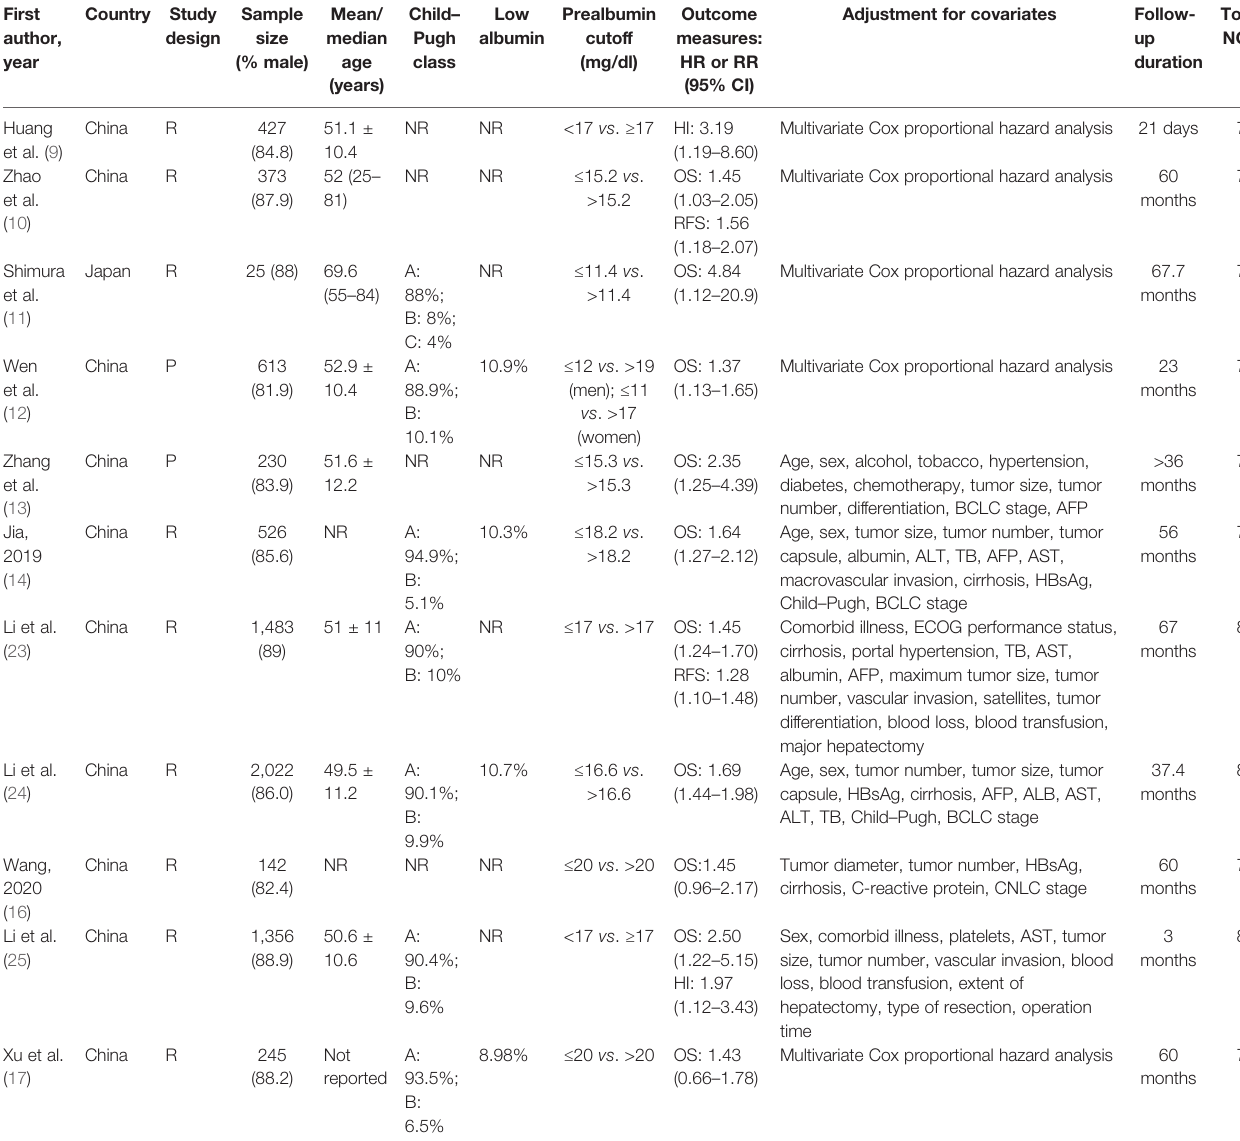
TABLE 1 | Main characteristics of individual